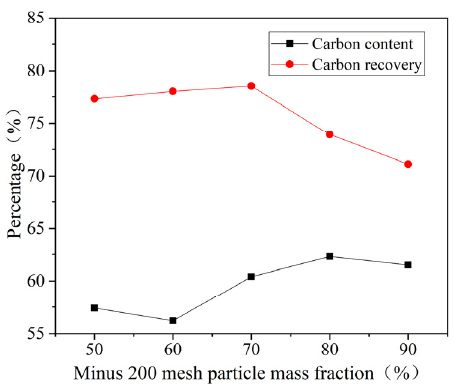
Figure 7. Effect of the mass of − 200 mesh particles on fl otation.